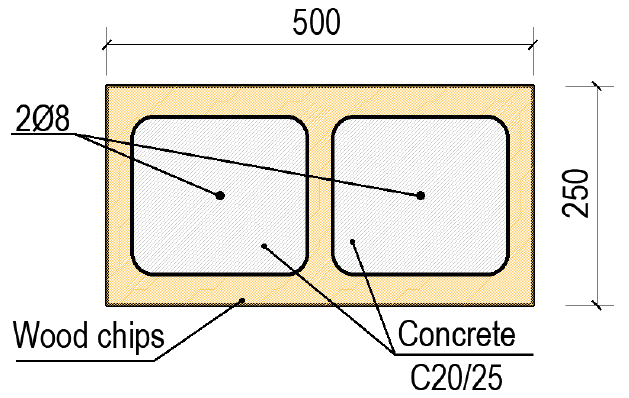
Figure 5. Configuration of block CBWC1.